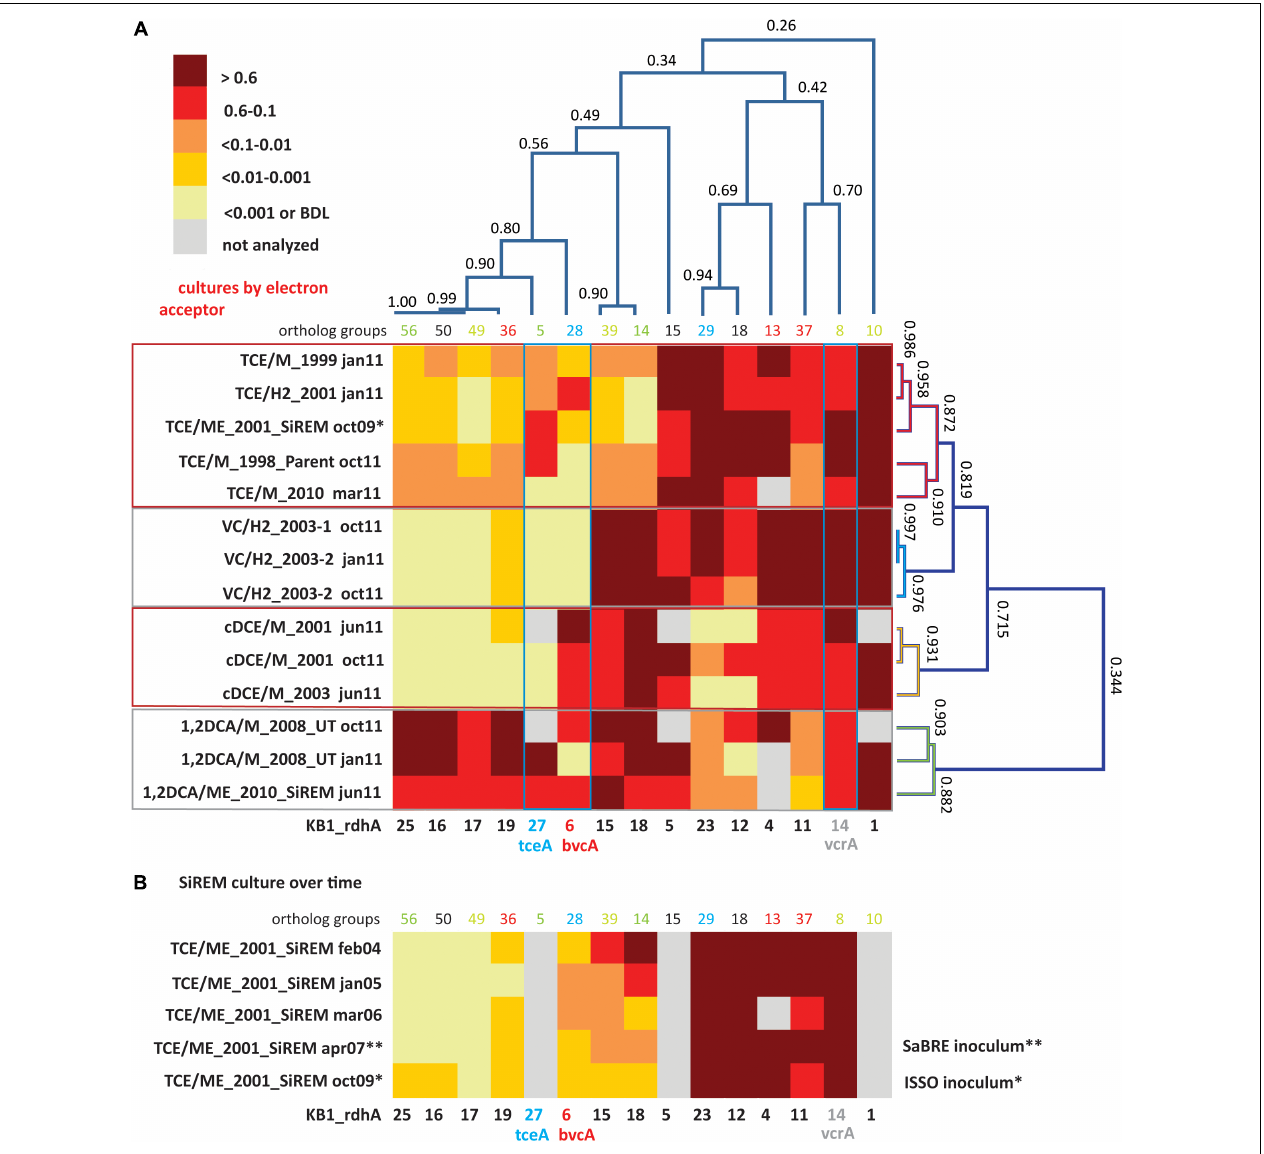
FIGURE 2 | Cluster analysis and heatmaps showing D. mccartyi rdhA /16S rRNA gene copy ratios measured in KB-1 enrichment cultures. (A) Shows how data clustered by the chlorinated electron acceptor amended to individual enrichment cultures as well as by rdhA sequence. The name format indicates electron acceptor amended/donor used_year created, followed by date sampled (e.g., TCE/M_1999 jan11 is a TCE and methanol enrichment culture first established in 1999 and sampled in January of 2011). The numbers on the cluster branches of both axes indicate the percentage similarity between samples based on the Pearson’s correlation coefficient. (B) It is a heatmap of rdhA /16S rRNA gene copy ratios in the SiREM KB-1 culture over 5 years. Cultures indicated with ∗ or ∗∗ are those used for bioaugmenting field sites in 2007 (SaBRE) and 2009